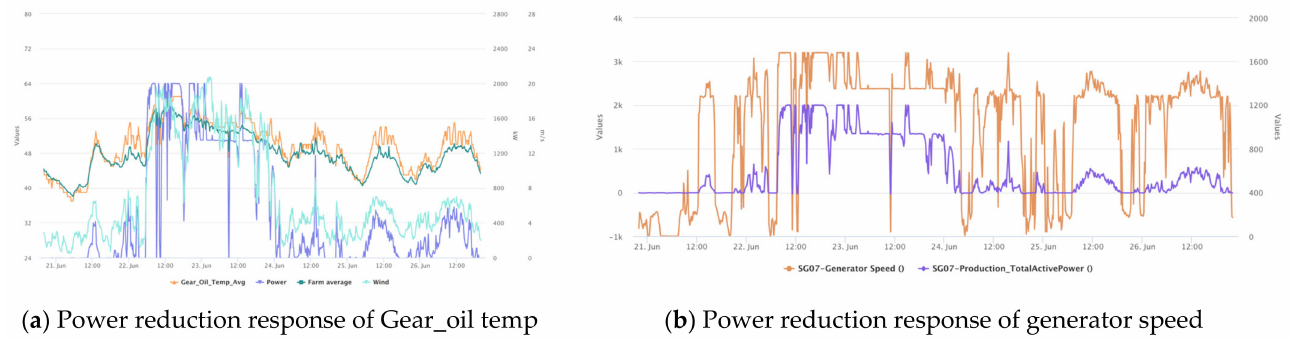
Figure 15. Real-time data response applying power